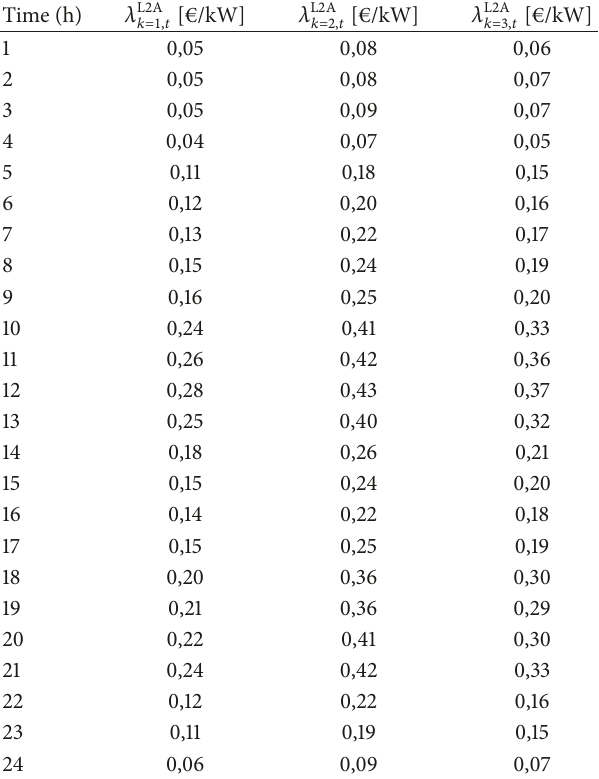
Table 3: Aggregator prices table obtained from [22]. Time